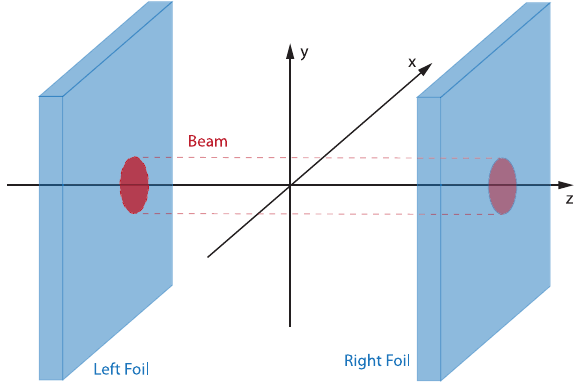
FIG. 4. Axisymmetric beam between two conducting foils located at z ¼ (cid:3) L= 2 . The foils are